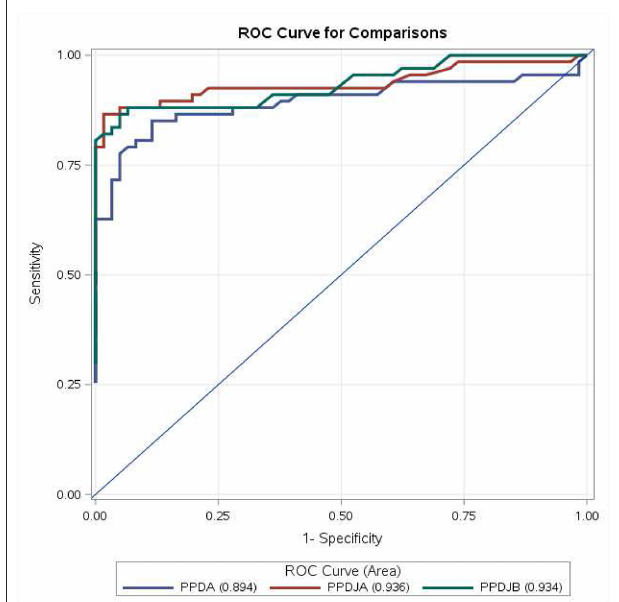
FIGURE 3 | ROC curve for comparisons of PPDA-PBS, PPDJA-PBS, and PPDJB-PBS according to the first three interpretative criteria of the IFN- γ test applied in the study for the diagnosis of Mycobacterium avium subsp. paratuberculosis (MAP)-infected cattle. PPDJA and PPDJB showed higher AUC than PPDA, and the difference is statistically significant ( p < 0.05). ROC, receiver operating characteristic; IFN, interferon; PPD, purified protein derivative; PPDA, avian PPD; PPDJA, PPD Johnin strain A; PPDJB, PPD Johnin strain B; AUC, area under the ROC curve.